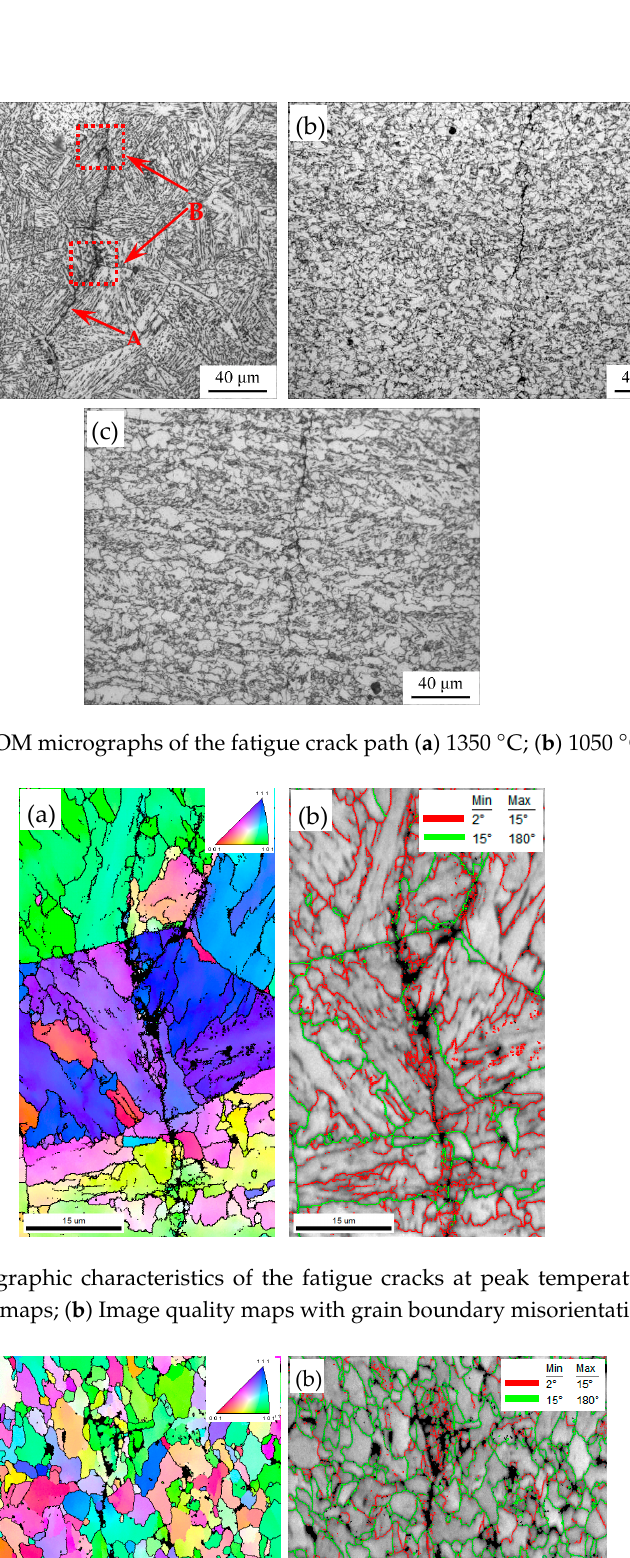
Figure 13. Number fraction of misoriented angles at different peak temperatures.